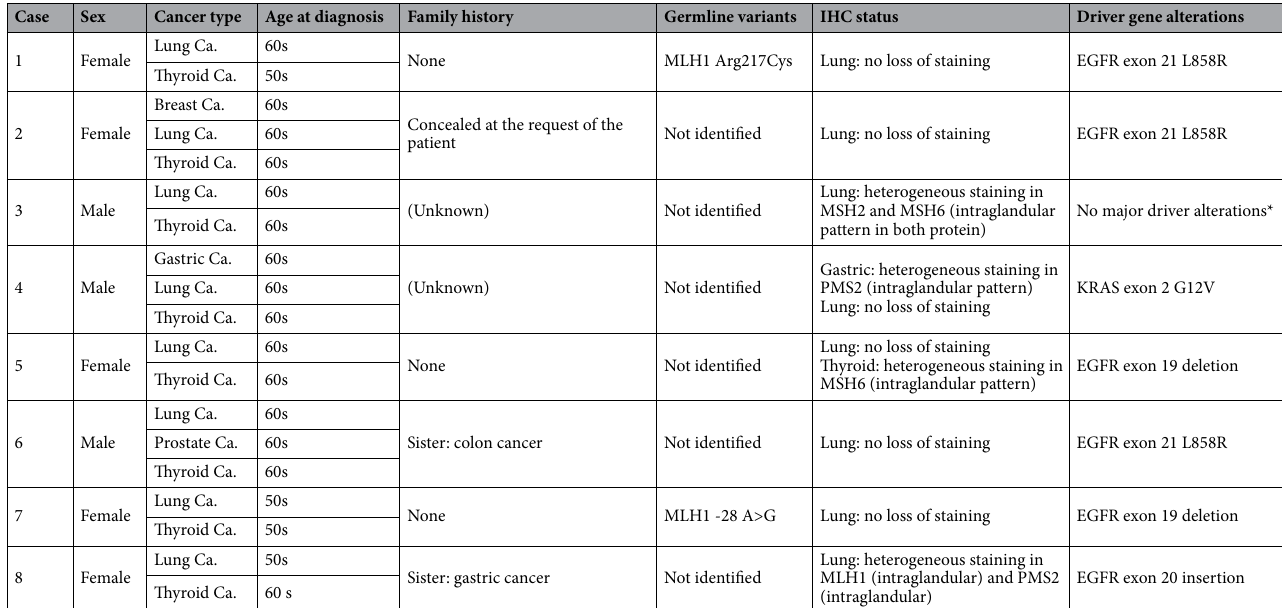
Table 3. Demographic, genetic and histologic characteristics with MMR immunohistochemistry. *Negative results (NGS on validated platforms) for oncogenic driver alteration: EGFR (exon 18–21) activating